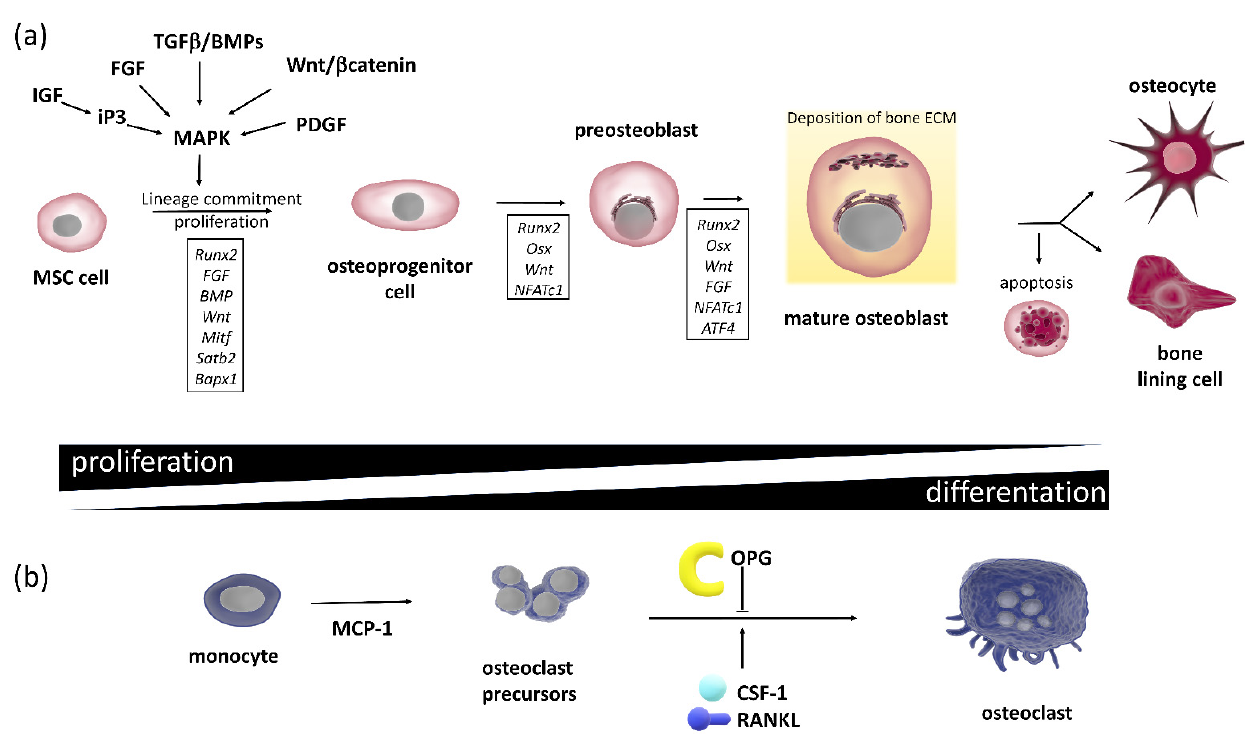
Figure 1. The principal signaling networks and transcription factors regulating bone cell differentiation. ( a ) Osteoblastogenesis and osteogenesis. In boxes, transcriptional factors, which characterize each stage of osteogenic differentiation, are shown. The MSC population actively proliferates at the initial stages of osteogenesis. As MSCs commit to osteoblasts, their proliferation rate decreases while they start expressing osteogenic genes. Following mineralization, mature osteoblasts undergo apoptosis, revert back to a bone lining phenotype or become embedded in the mineralized matrix and differentiate into osteocytes. Lines with an arrowhead indicate a positive action, and lines with a bar indicate inhibition. ( b ) Osteoblast cytokines involved in osteoclastogenesis: osteoblasts produce chemokine MCP-1 (monocyte chemoattractant protein-1). In addition, osteoblasts express the master of osteoclastogenesis cytokines, i.e., CSF-1 (light blue sphere), RANKL (represented in dark blue) and OPG (yellow semicircle). Monocytes (differentiated from HSCs) evolve to osteoclast precursors and finally to active OC forms which are stimulated by RANKL. Together with the canonical Wnt signaling, the RANK/RANKL OPG signaling pathways control osteoclasts in response to the actual extracellular stimuli.